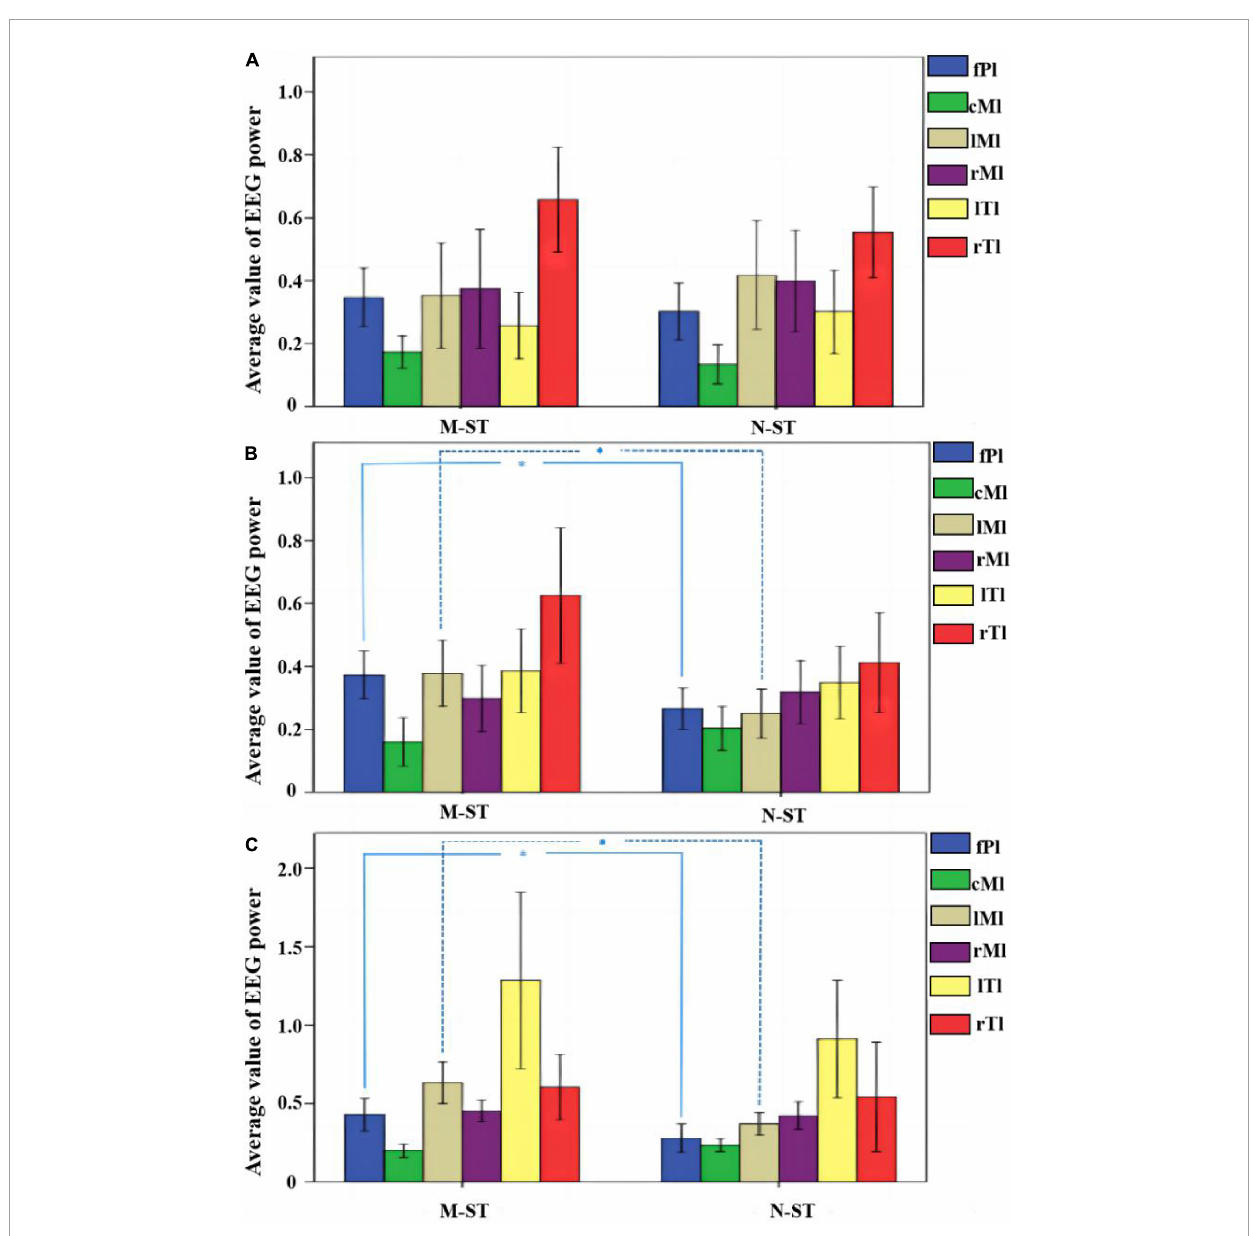
FIGURE3 Average normalized EEG power across all the 18 subjects for M-ST task and N-ST task. (A) The mean normalized EEG power within the alpha band. (B) The mean normalized EEG power within the beta band. (C) The mean normalized EEG power within the gamma band. *Refers to p < 0.05 with one-way ANOVA. The statistical results showed that the activity of FPL and LML area was significantly increased in bate band and gamma